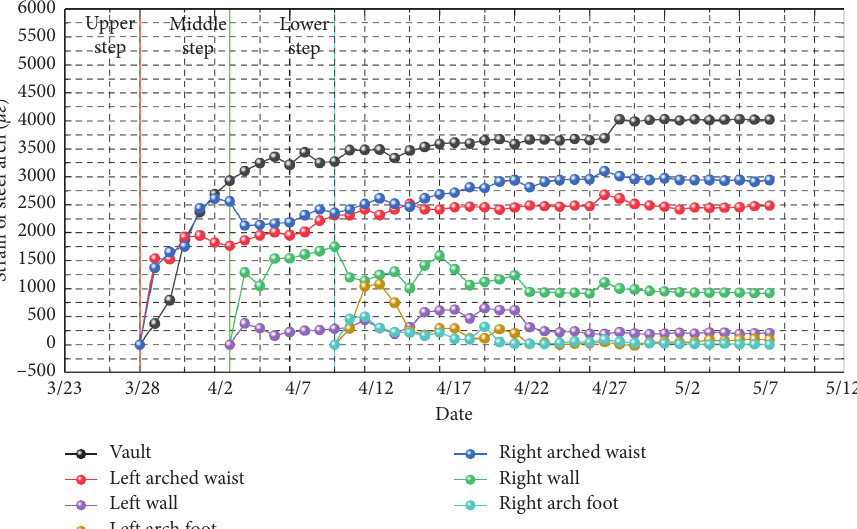
Figure 8: Strain of the steel arch in section ZK11+430.